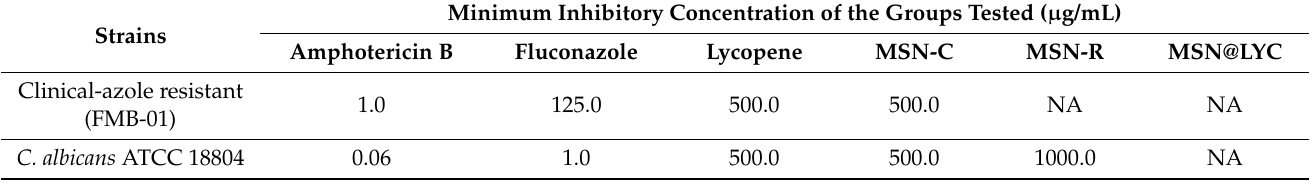
Table 2. The minimum inhibitory concentration of the groups tested.